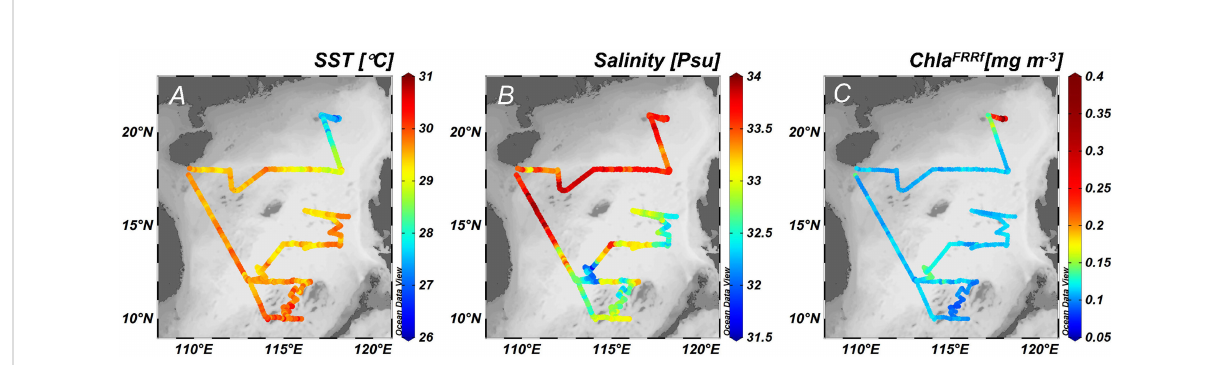
FIGURE 2 Underway surface sea temperature (SST) (A) , surface salinity (B), and surface fl uorescence (Chl a FRRf ) (C) during the